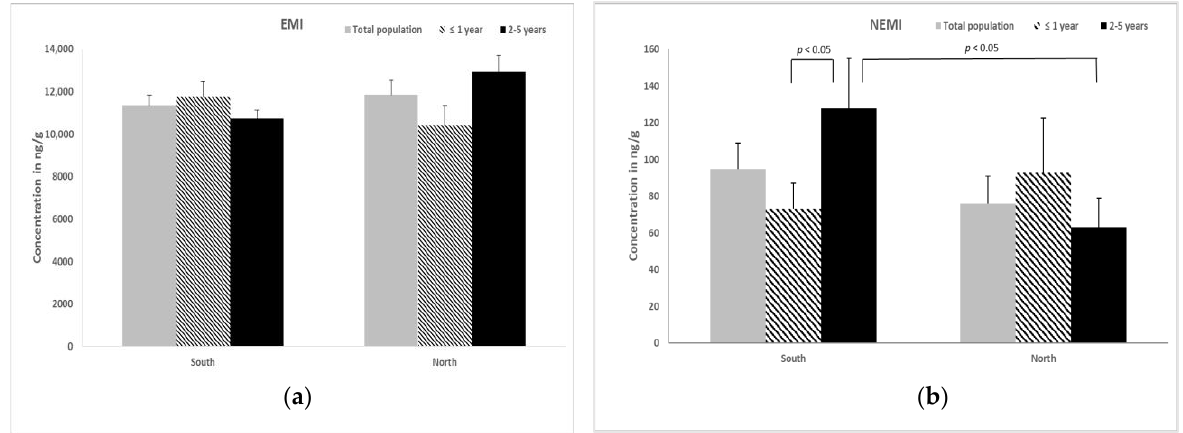
Figure 1. The mean ± SEM of ( a ) the essential metal index (EMI) and ( b ) the non-essential metal index (NEMI) in the ovarian tissues of free-ranging queens of different groups.